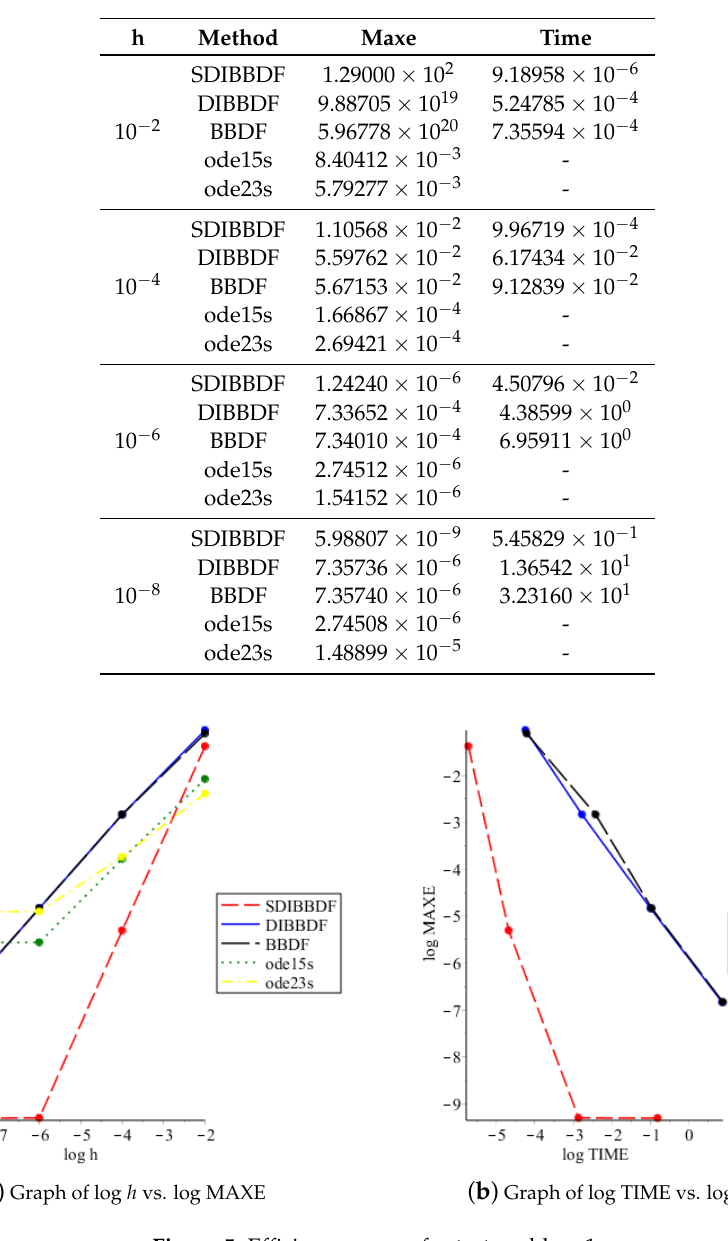
Table 5. Numerical results for test problem 4.